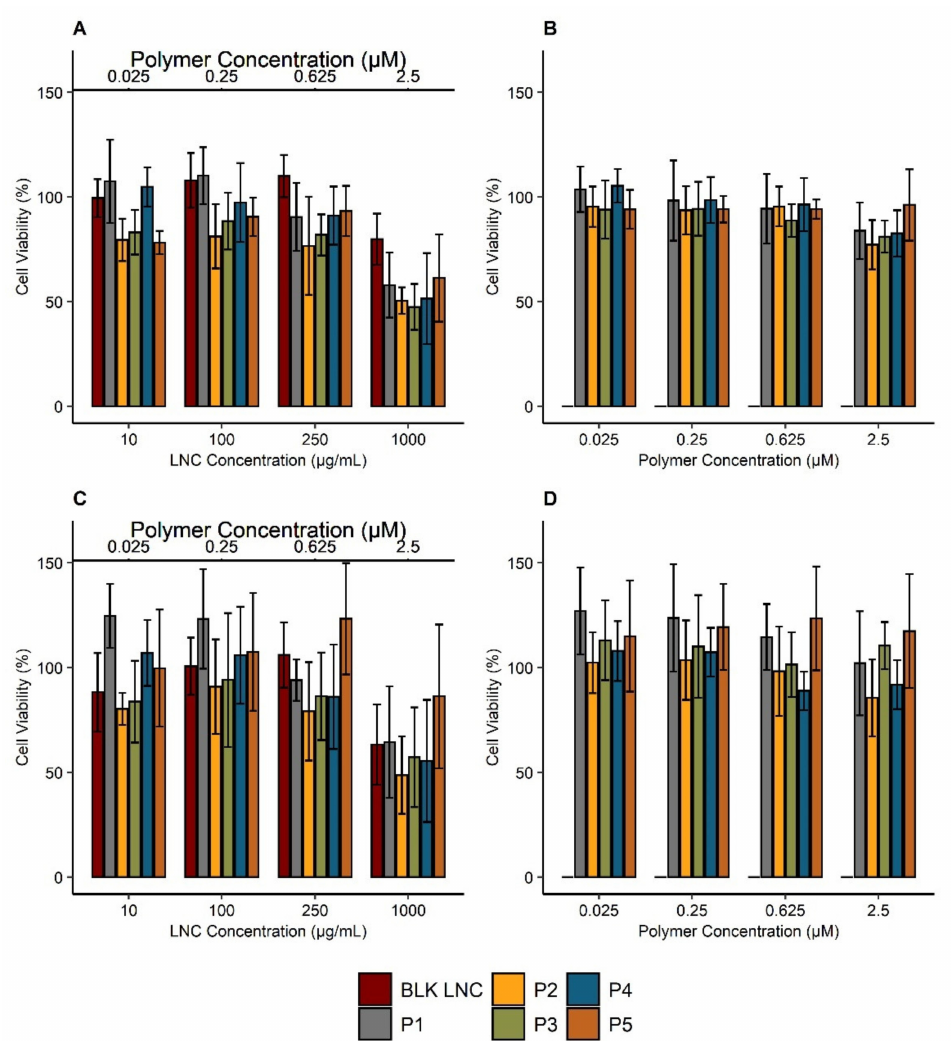
Figure 5. Cell viability of B16F10 and SK-Mel 28 cell lines treated with polymers and modified LNC. Cells were incubated with blank LNC (“BLK”) and LNC post-inserted by C 18 H 37 -PNVP 49 (“P1”), C 18 H 37 -P(NVP 15 -co-Vim 5 ) (“P2”), C 18 H 37 -P(NVP 22 -co-Vim 8 ) (“P3”), C 18 H 37 -P(NVP 35 -co- Vim 10 ) (“P4”) and C 18 H 37 -P(NVP 21 -co-Vim 15 ) (“P5”) (concentration range: 10–1000 µ g/mL) for 24 h: B16F10 ( A ), SK-Mel 28 ( C ). In addition, to evaluate the impact of polymers alone, cells were treated with polymers at concentrations corresponding to the amount of post-inserted polymers into LNC (0.025 µ M–2.5 µ M): B16F10 ( B ), SK-Mel 28 ( D ). Cell viability was then measured by resazurin reduction assay. Results ( n = 6) are expressed as the means ±